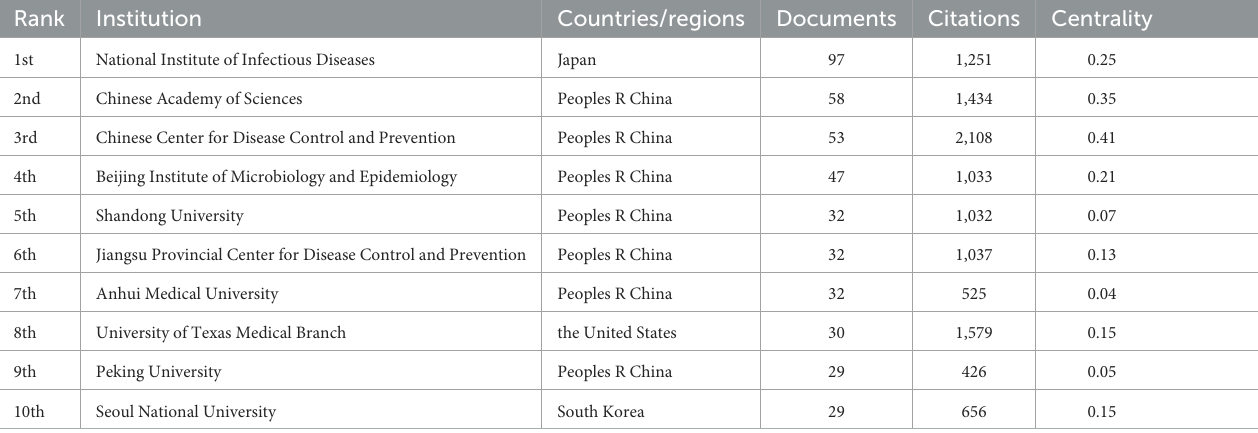
TABLE 3 The top 10 institution in number of publications concerning